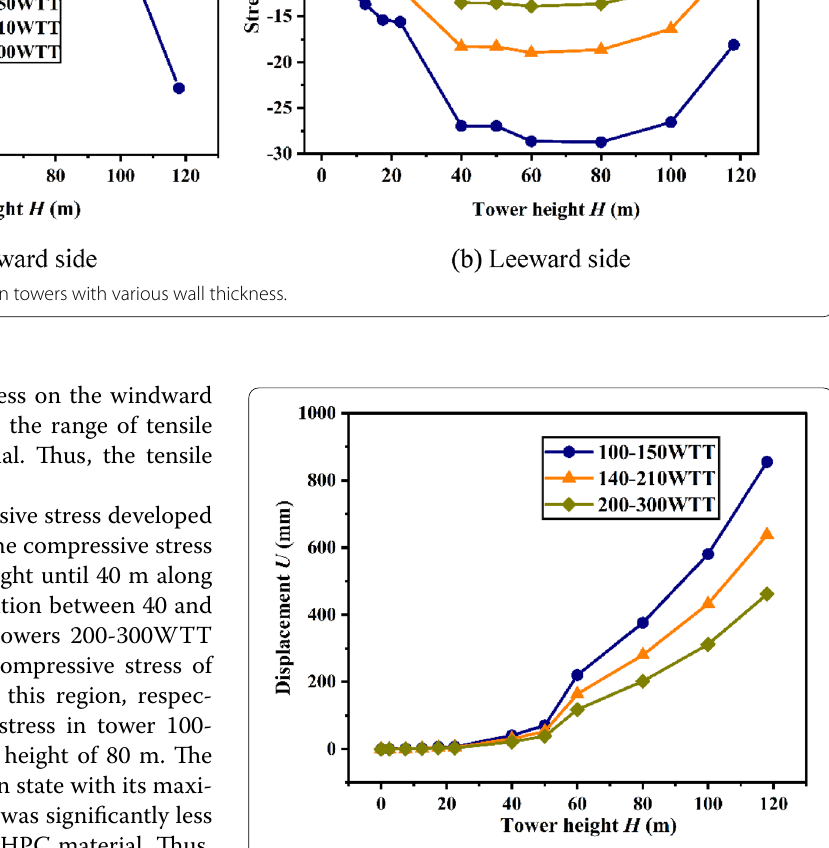
Fig. 6 Displacement distribution of UHPC segment in towers with various wall